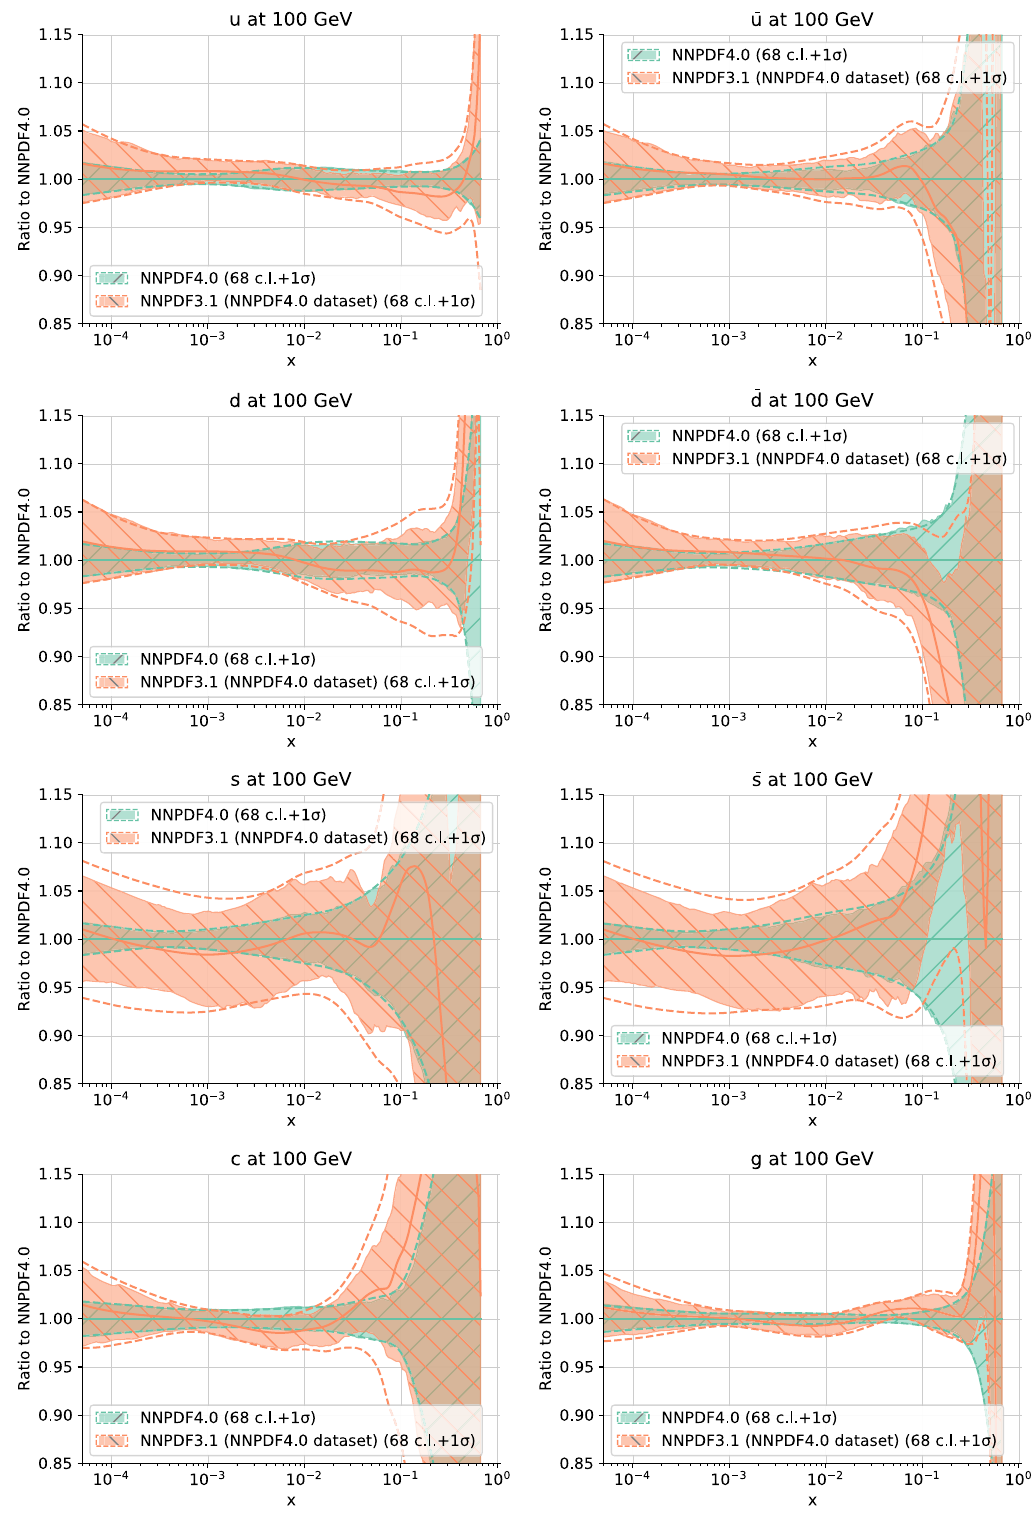
Fig. 45 Same as Fig. 33 but now presenting the complementary comparison of the baseline of PDFs to a set based on the same NNPDF4.0 dataset, but using the old NNPDF3.1